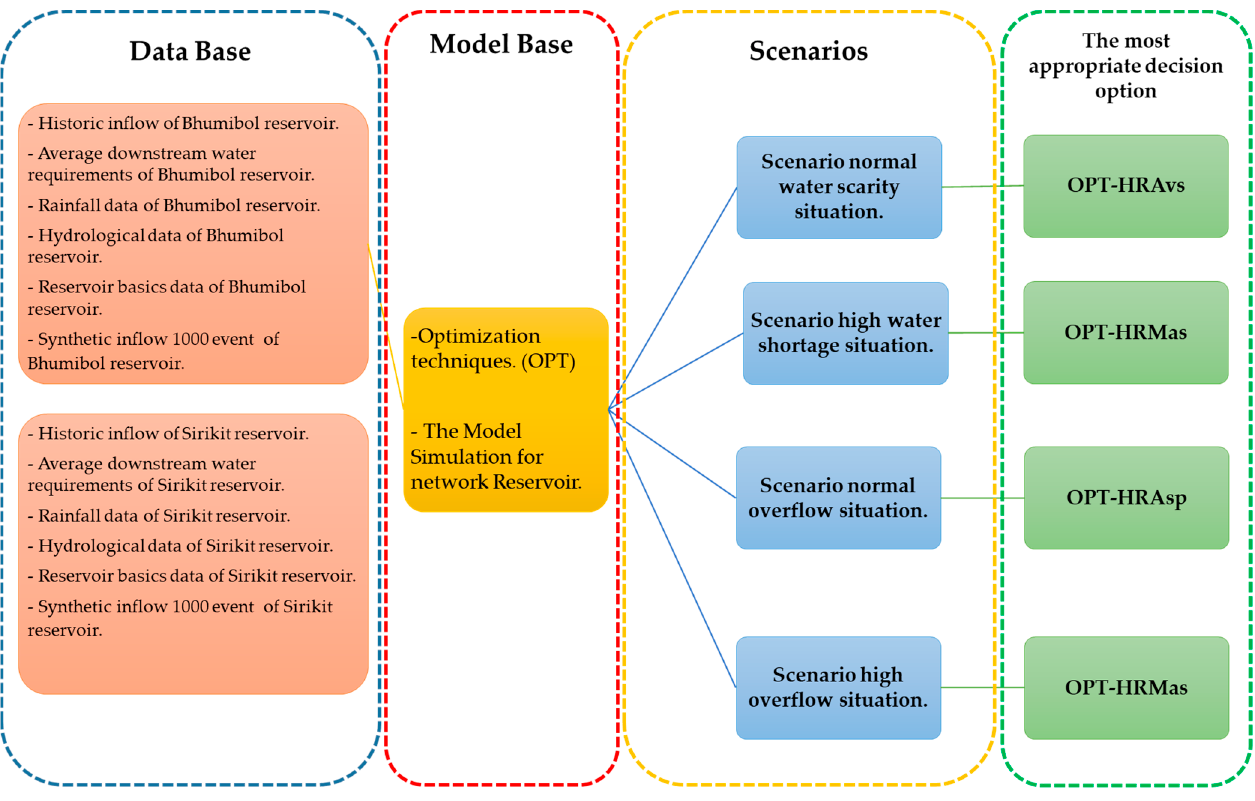
Figure 7. The decision-making process for management options of network reservoirs.